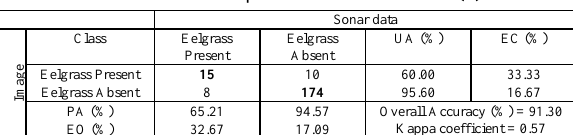
Table12. Confusion matrix (in GPS sonar points) and associated accuracies when the UAV classified image of Souris is compared to the sonar data (*).